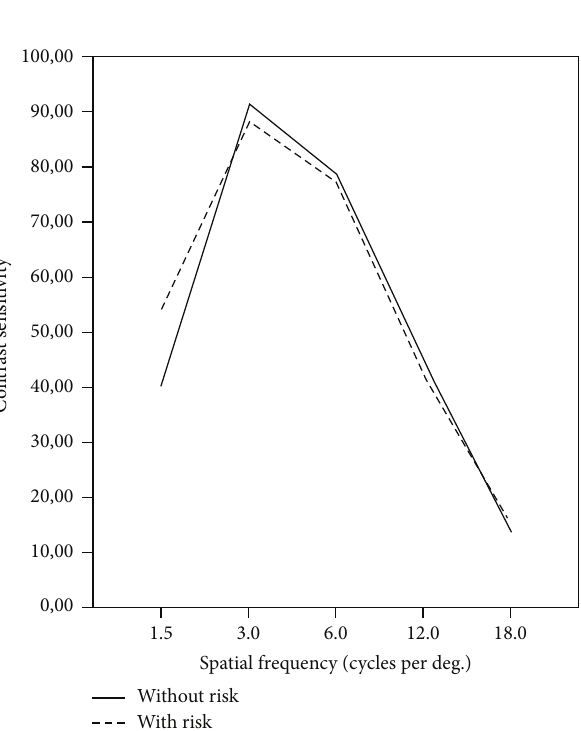
Figure 1: Contrast sensitivity function between diabetic patients (solid line) and control subjects (dashed/dotted line) ( 𝑝 > 0.05 ).